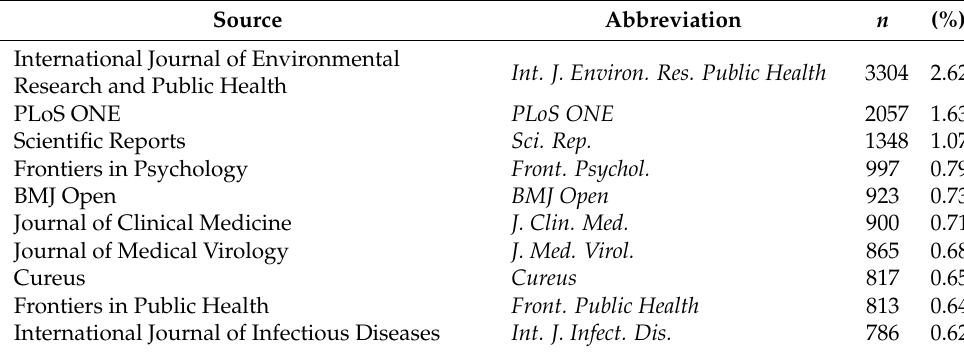
Table 3. Top 10 most important sources in terms of number of